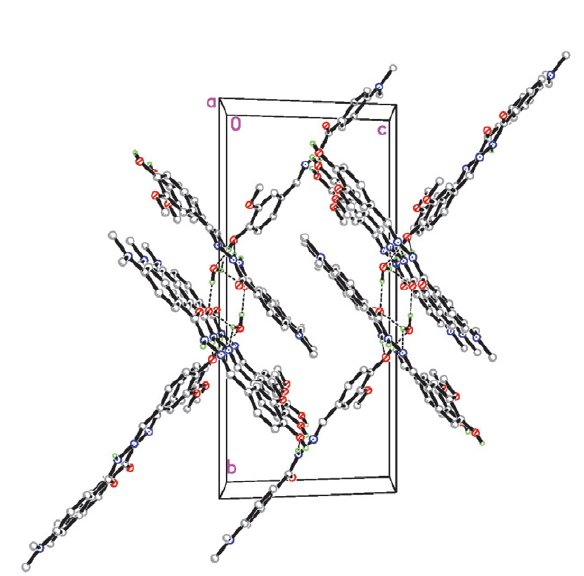
Figure 4. The packing diagram of 2 . Hydrogen bonding interac- tions are shown as dashed lines.